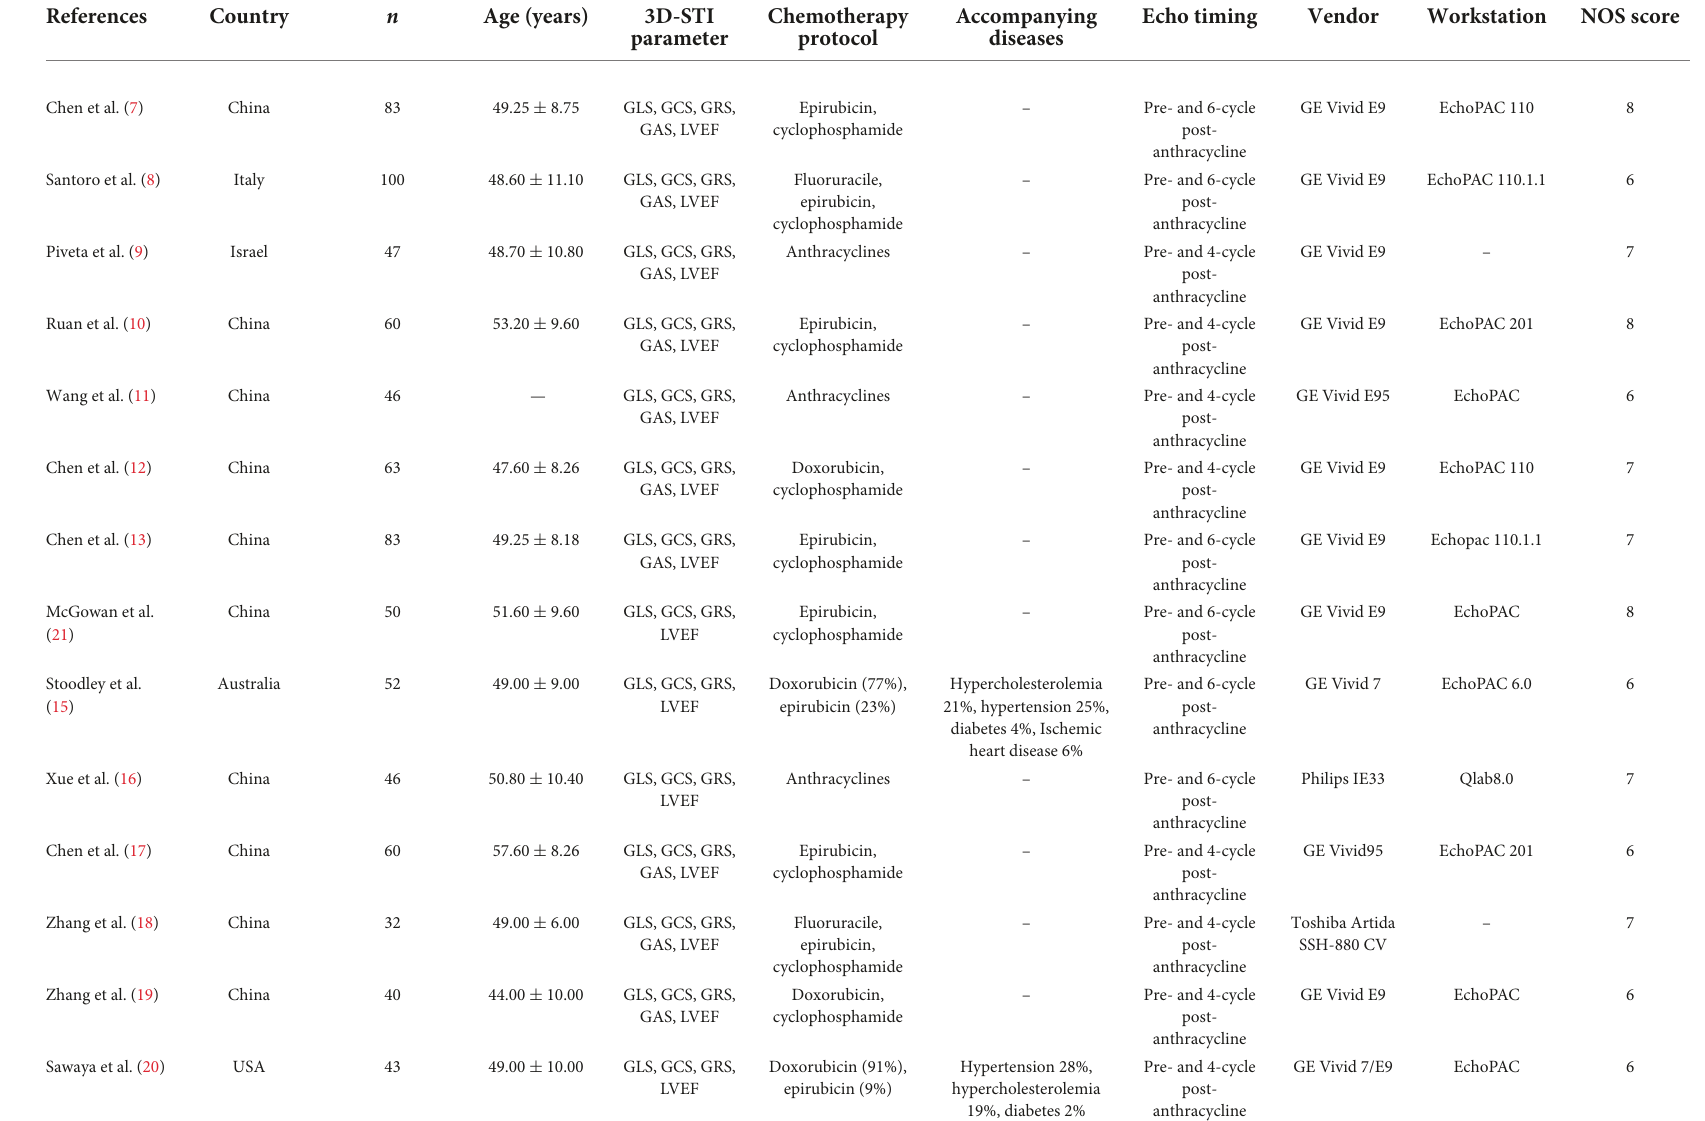
TABLE 1 Summary of General information and quality assessment of the included literature.